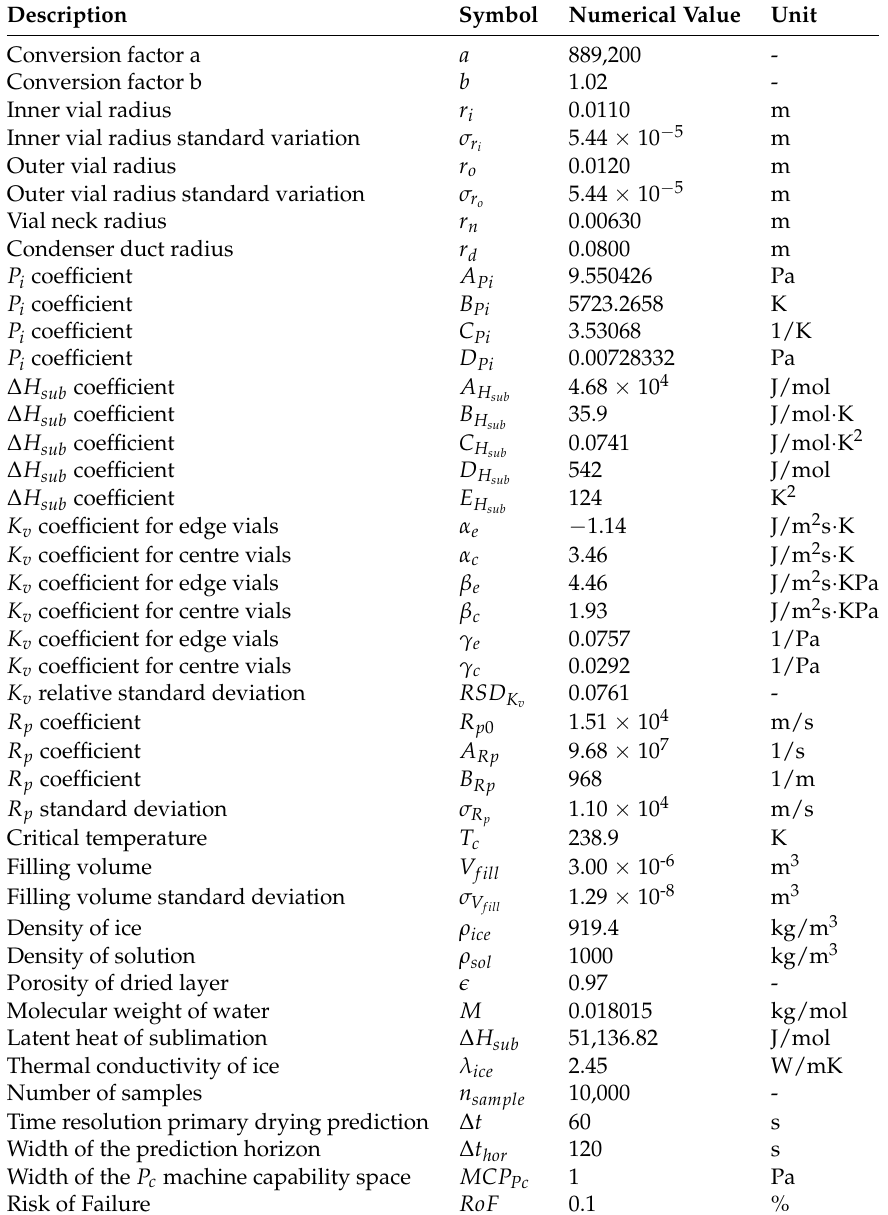
Table 2. Nominal values of the parameters and constants for the proposed model-based optimisation and control